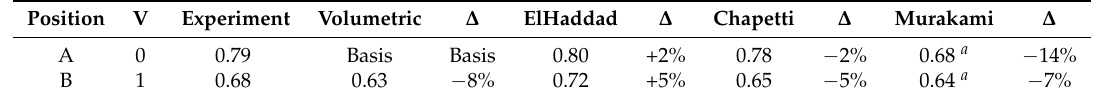
Table 4. Comparison of the fatigue assessment